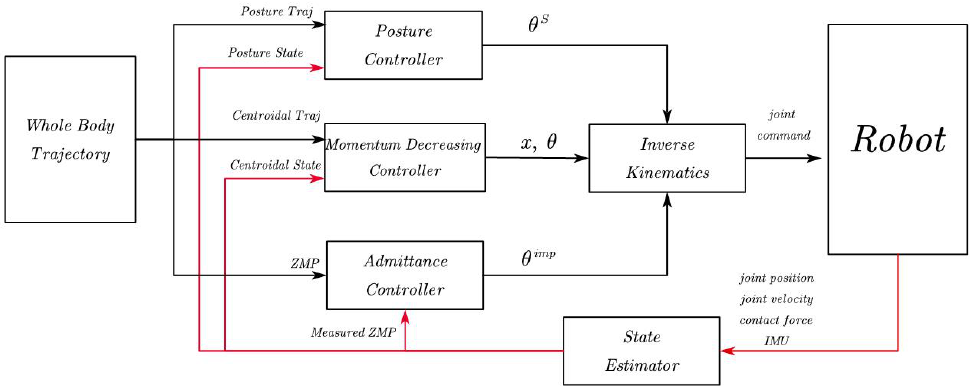
Figure 6. Overall control framework. In the single and double support phases, different controllers are enabled for trajectory control. The momentum decreasing controller and the admittance controller are enabled only in the double support phase. The red line represents the feedback